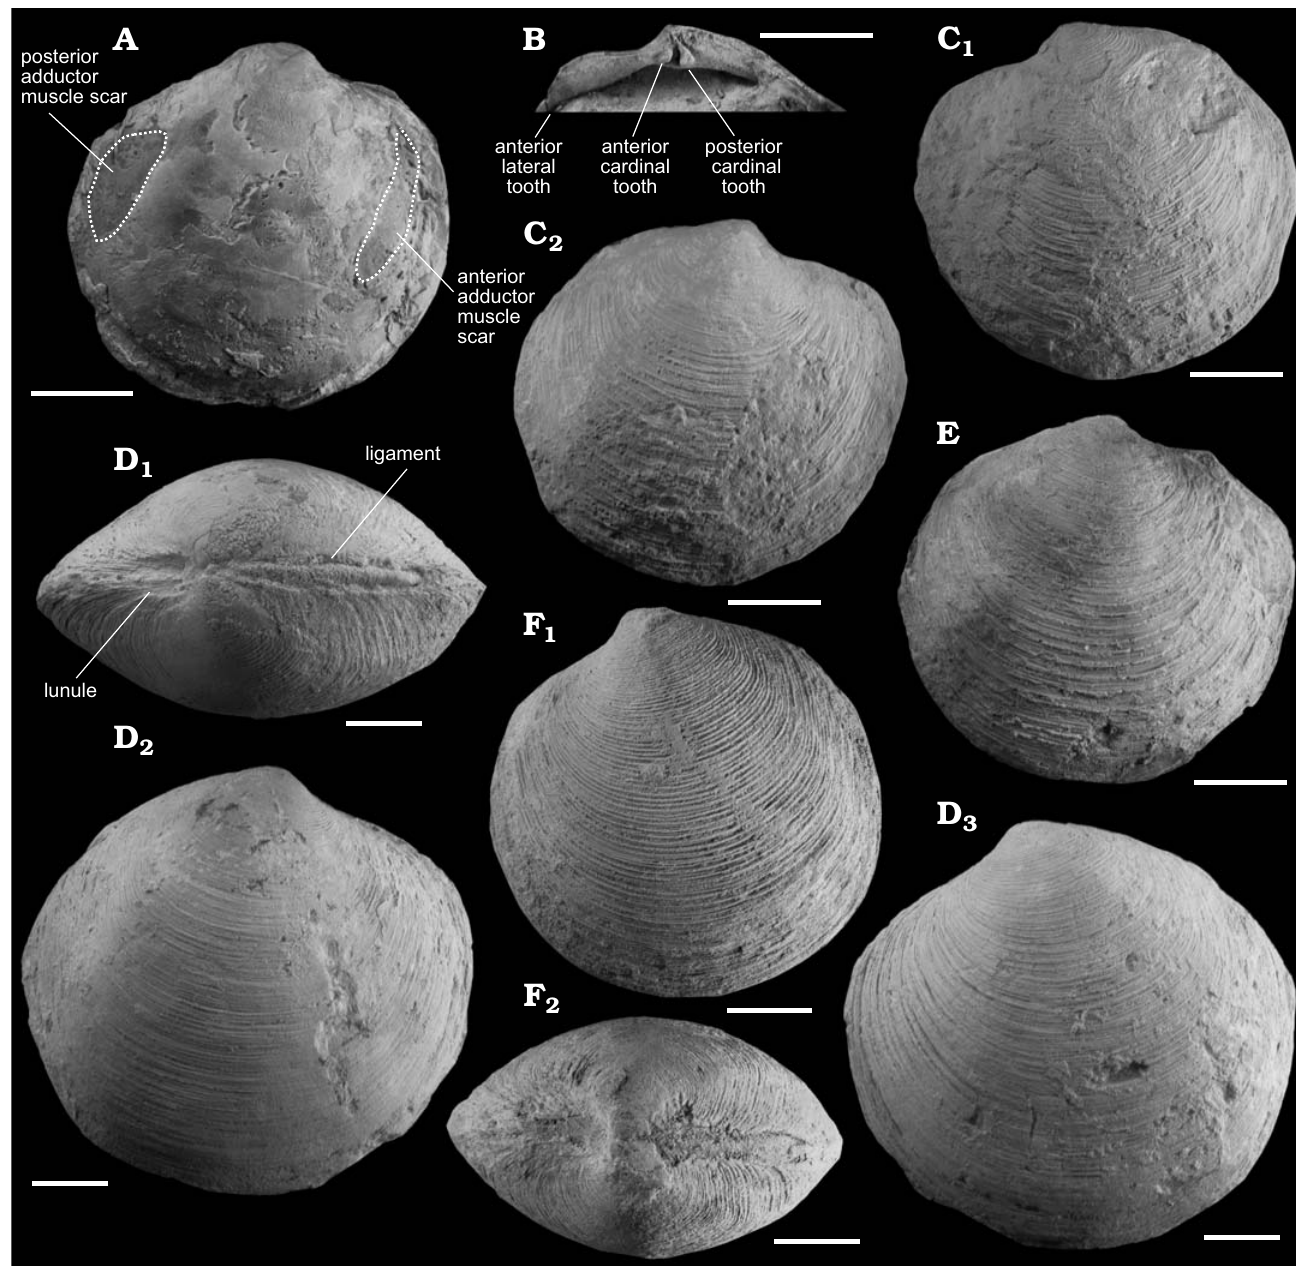
Fig. 5. Lucinid bivalve Lucinoma saetheri sp. nov. from the lower Miocene Ihungia Limestone at Ugly Hill (D, F, U23/266) and the middle Miocene Bexhaven Limestone at Moonlight North (A, C, E, Y16/1059; B, Y16/f1174), North Island, New Zealand. A . UOA L4773 (paratype), internal mould of right valve. B . UOA L 4772 (paratype), hinge plate of right valve. C . UOA L4785, left (C 1 ) and right (C 2 ) valves. D . UOA L4780 (holo type), dorsal view (D 1 ), right (D 2 ) and left (D 3 ) valves. E . UOA L4786, right valve. F . UOA L 4779 (paratype), left valve showing lamellated commarginal riblets (F 1 ), dorsal view (F 2 ). Scale bars 10